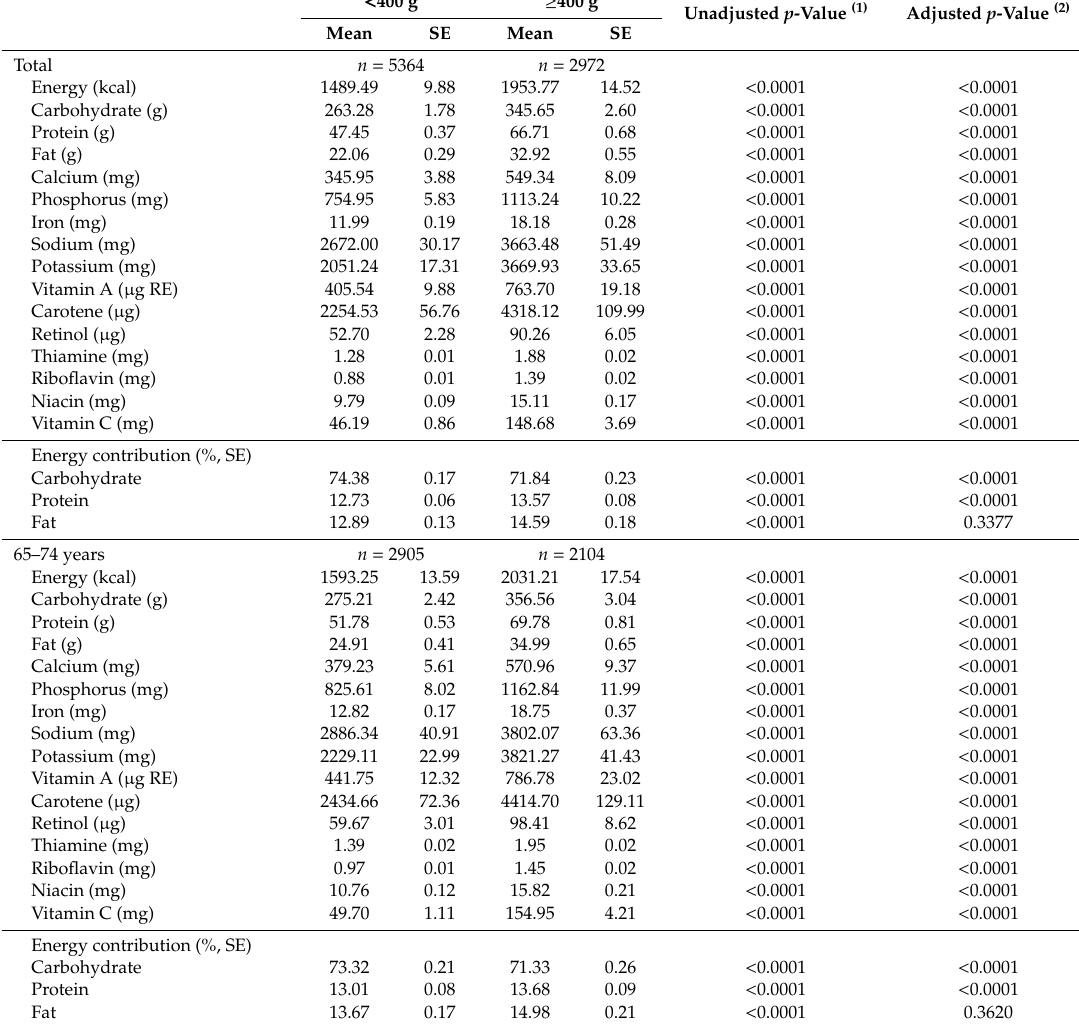
Table 5. Nutrient intake according to grouping of recommended fruits and vegetables intake. < 400